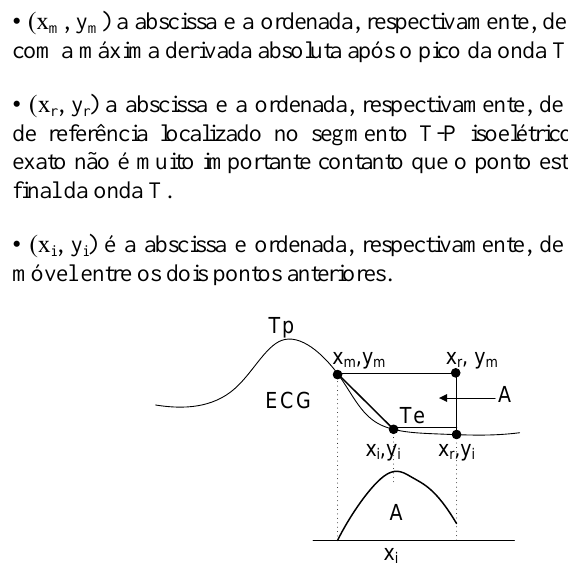
Figura 4. Determinação do final da onda T (ponto Te) para uma onda monofásica mediante o calculo das áreas dos